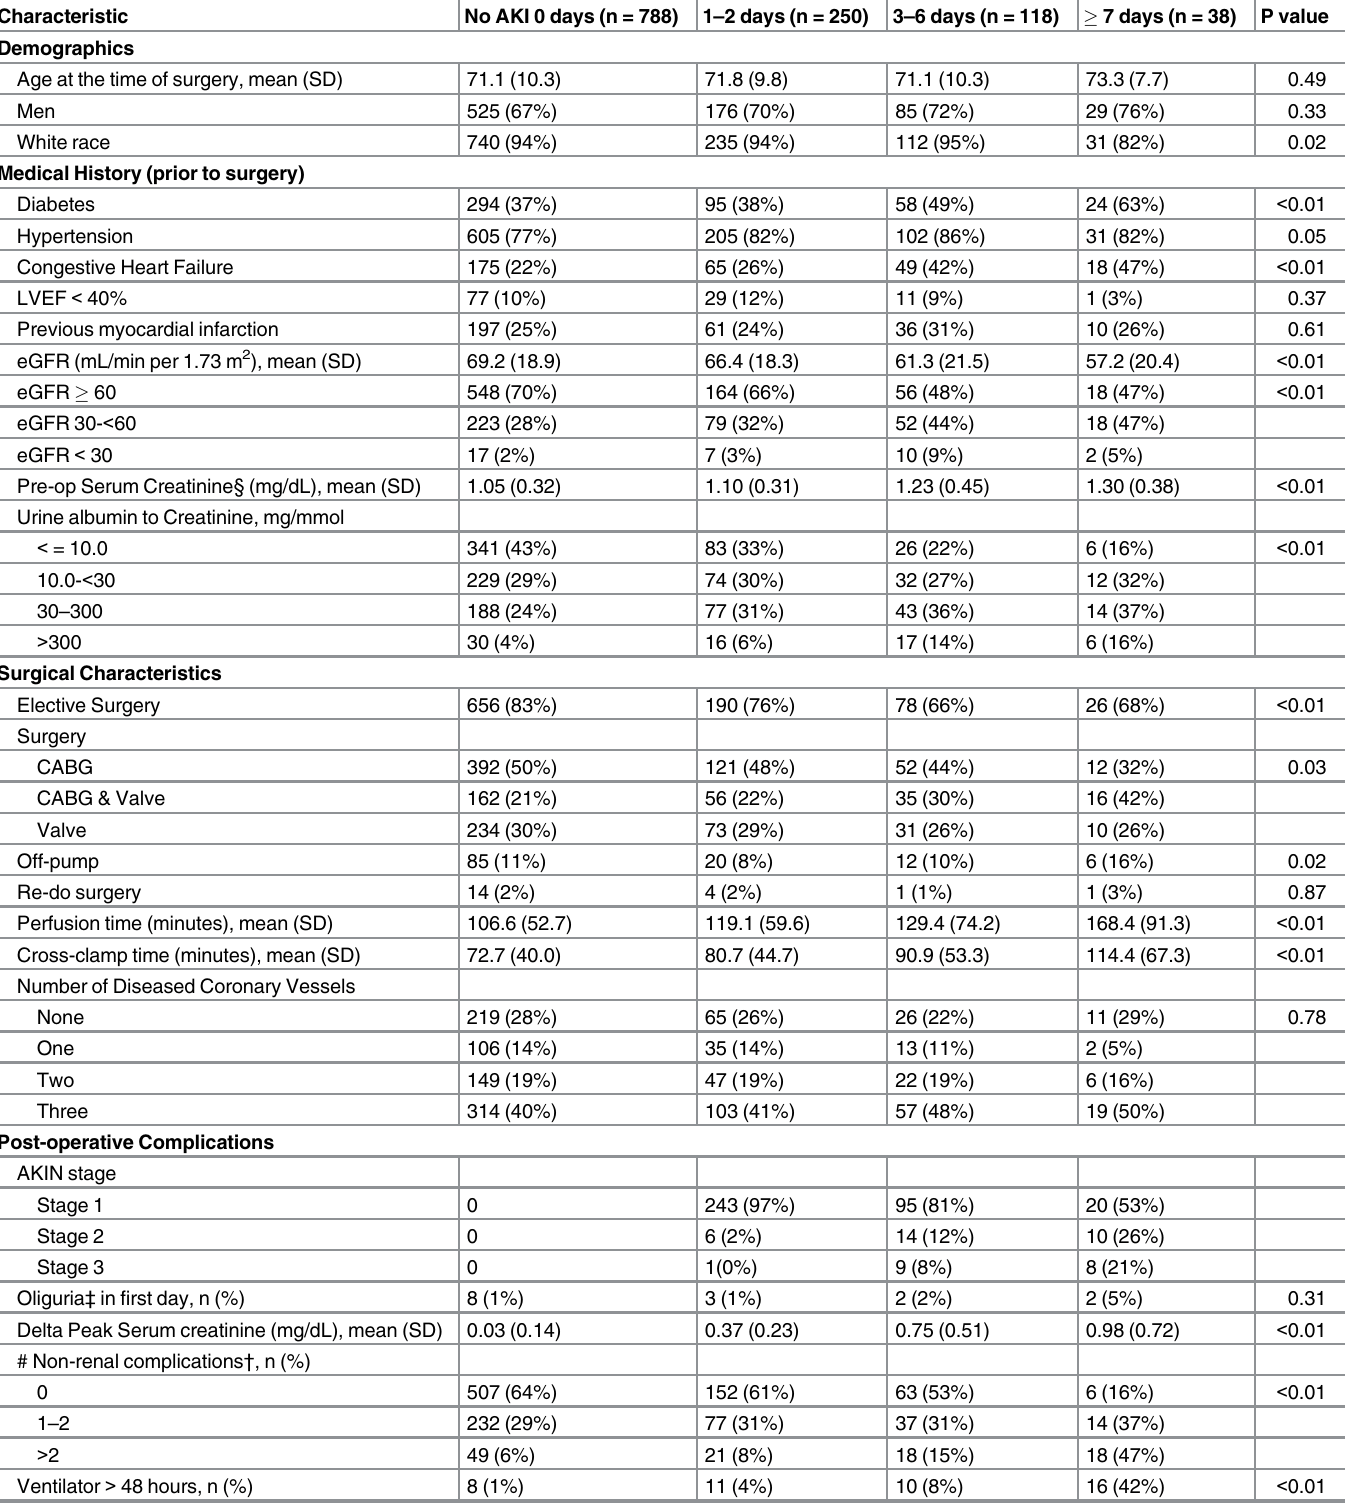
Table 1. Patient Characteristics by Duration of AKI (n = 1194).